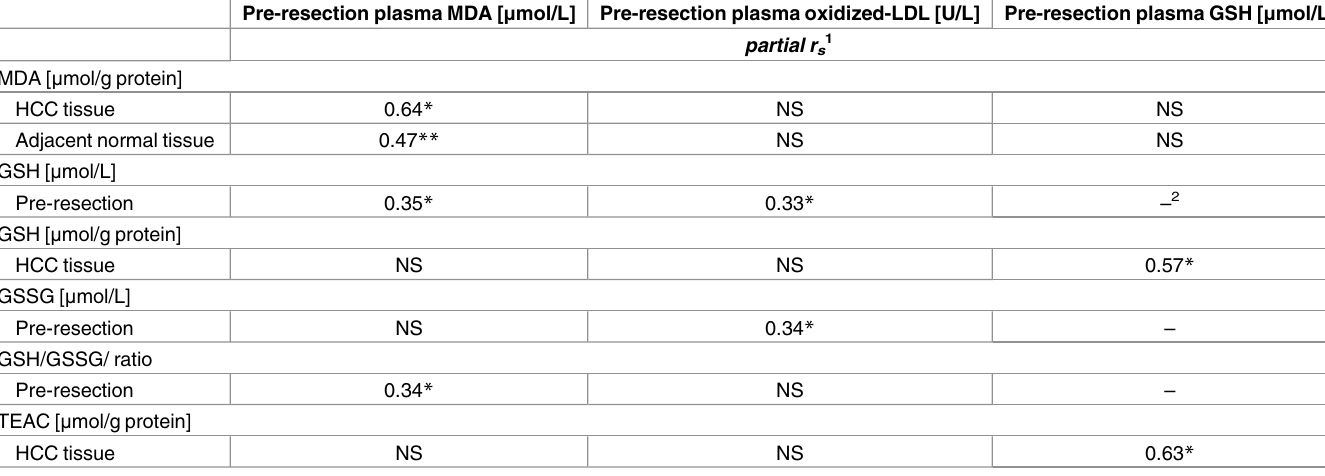
Table 4. Partial Spearman’s correlation coefficients [ r s ] of oxidative stresswith glutathione, oxidized glutathione, and antioxidant capacities in plasma and